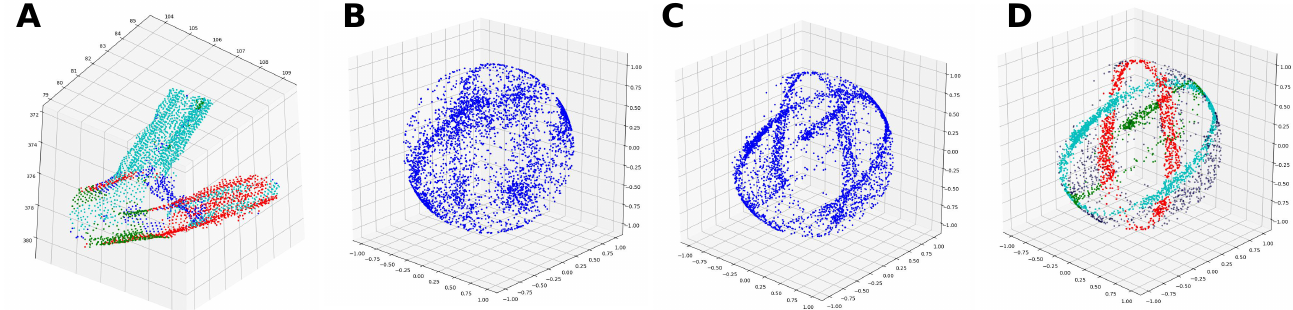
Figure 2. Gaussian spheres. ( A ) Points that correspond to an example fork node. ( B ) Mapping of normal vectors to a Gaussian sphere. ( C ) Mapping of smoothed normals to a Gaussian sphere. ( D ) Correspondence between colored rings and original branches in panel A.